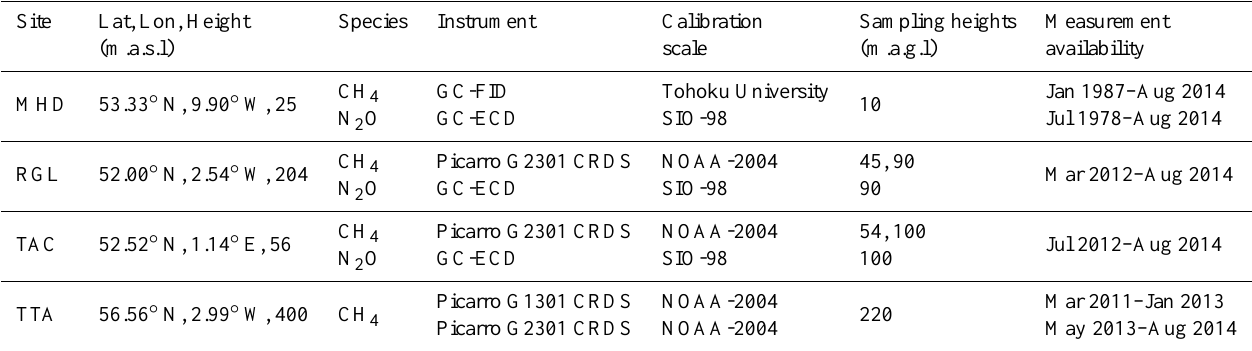
Table 5. Ancillary measurement information for the data used this study.